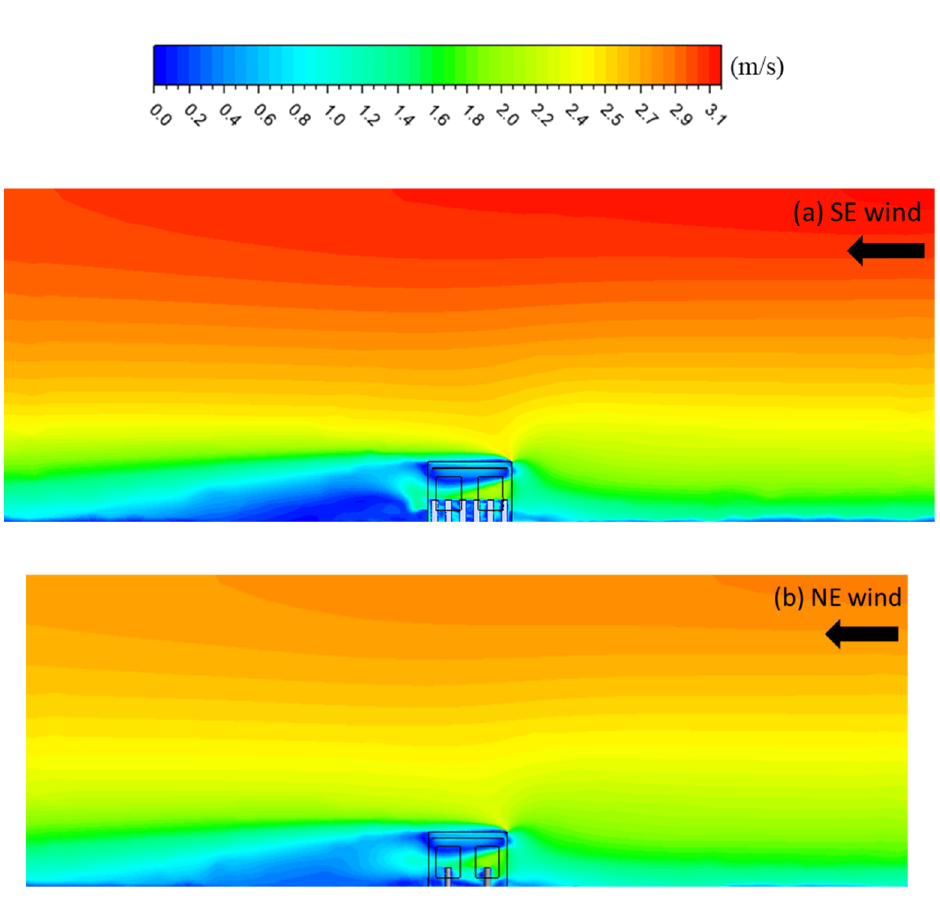
Figure A3. Velocity contours on the vertical plane through middle of window opening for ( a ) south-east wind and ( b ) north-east wind.